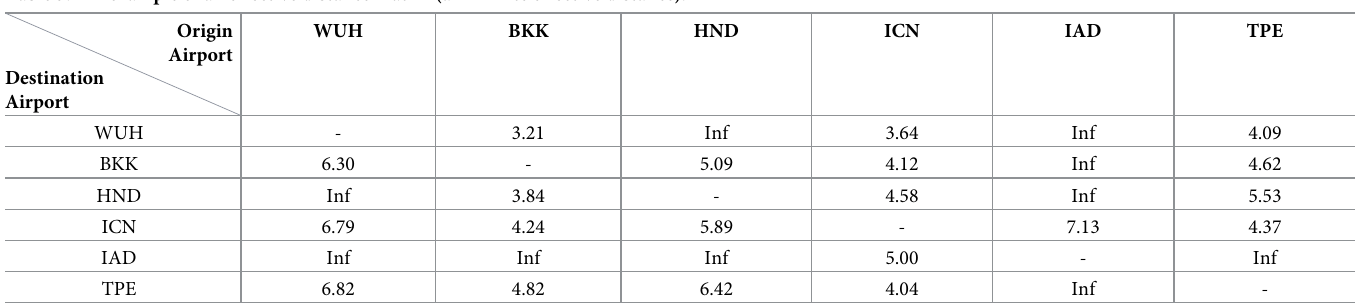
Table 3. An example of an effective distance matrix (an infinite effective distance).